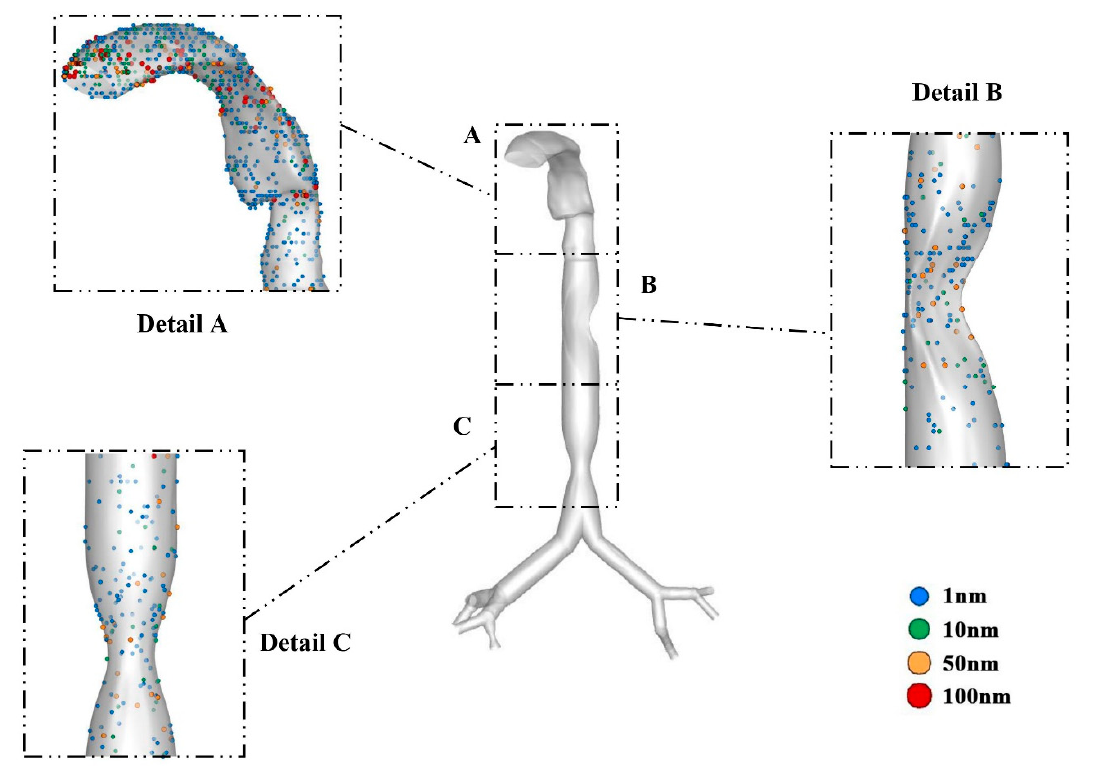
Figure 12. Particle deposition scenario with hotspot regions at a 25 L/min airflow